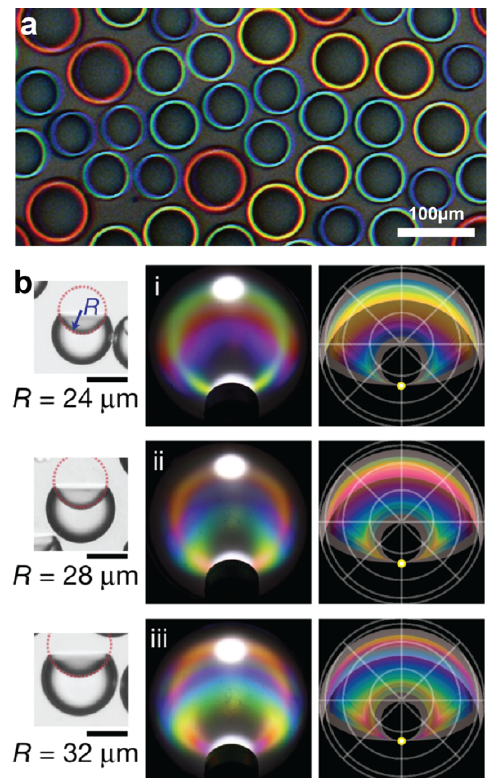
Fig. 3. a) Poly-disperse bi-phase emulsion droplets showing a size dependence of their color. b) Comparison of experimental iridescence maps of index-matched Janus droplets with the predicted three-dimensional calculation for various